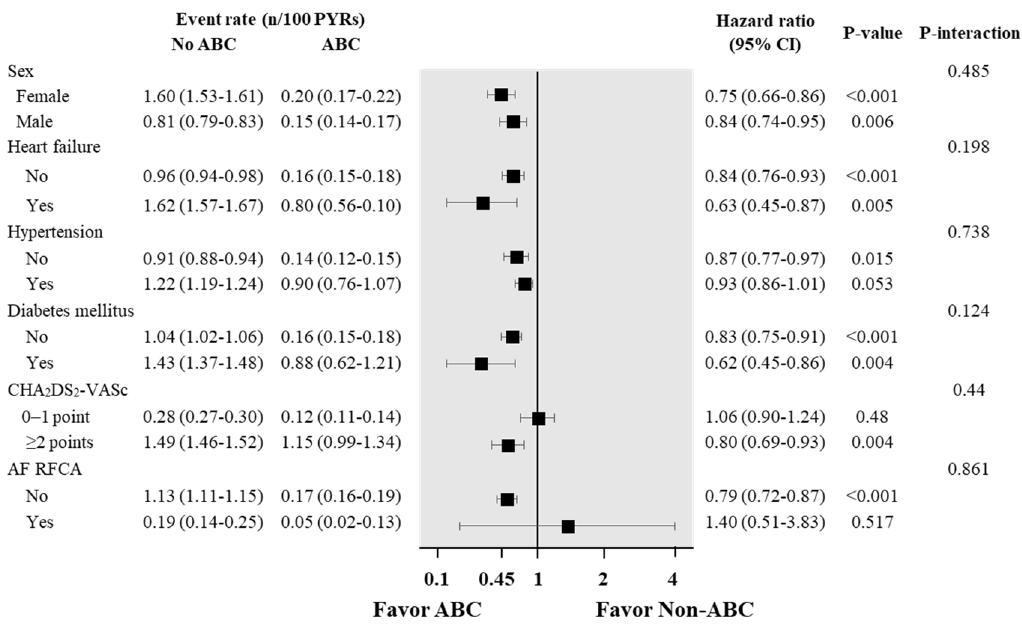
Figure 4. Events, event rates, and risk of dementia according to the use of integrated care (ABC) in different subgroups. CI = confidence interval; PYRs = person-years.